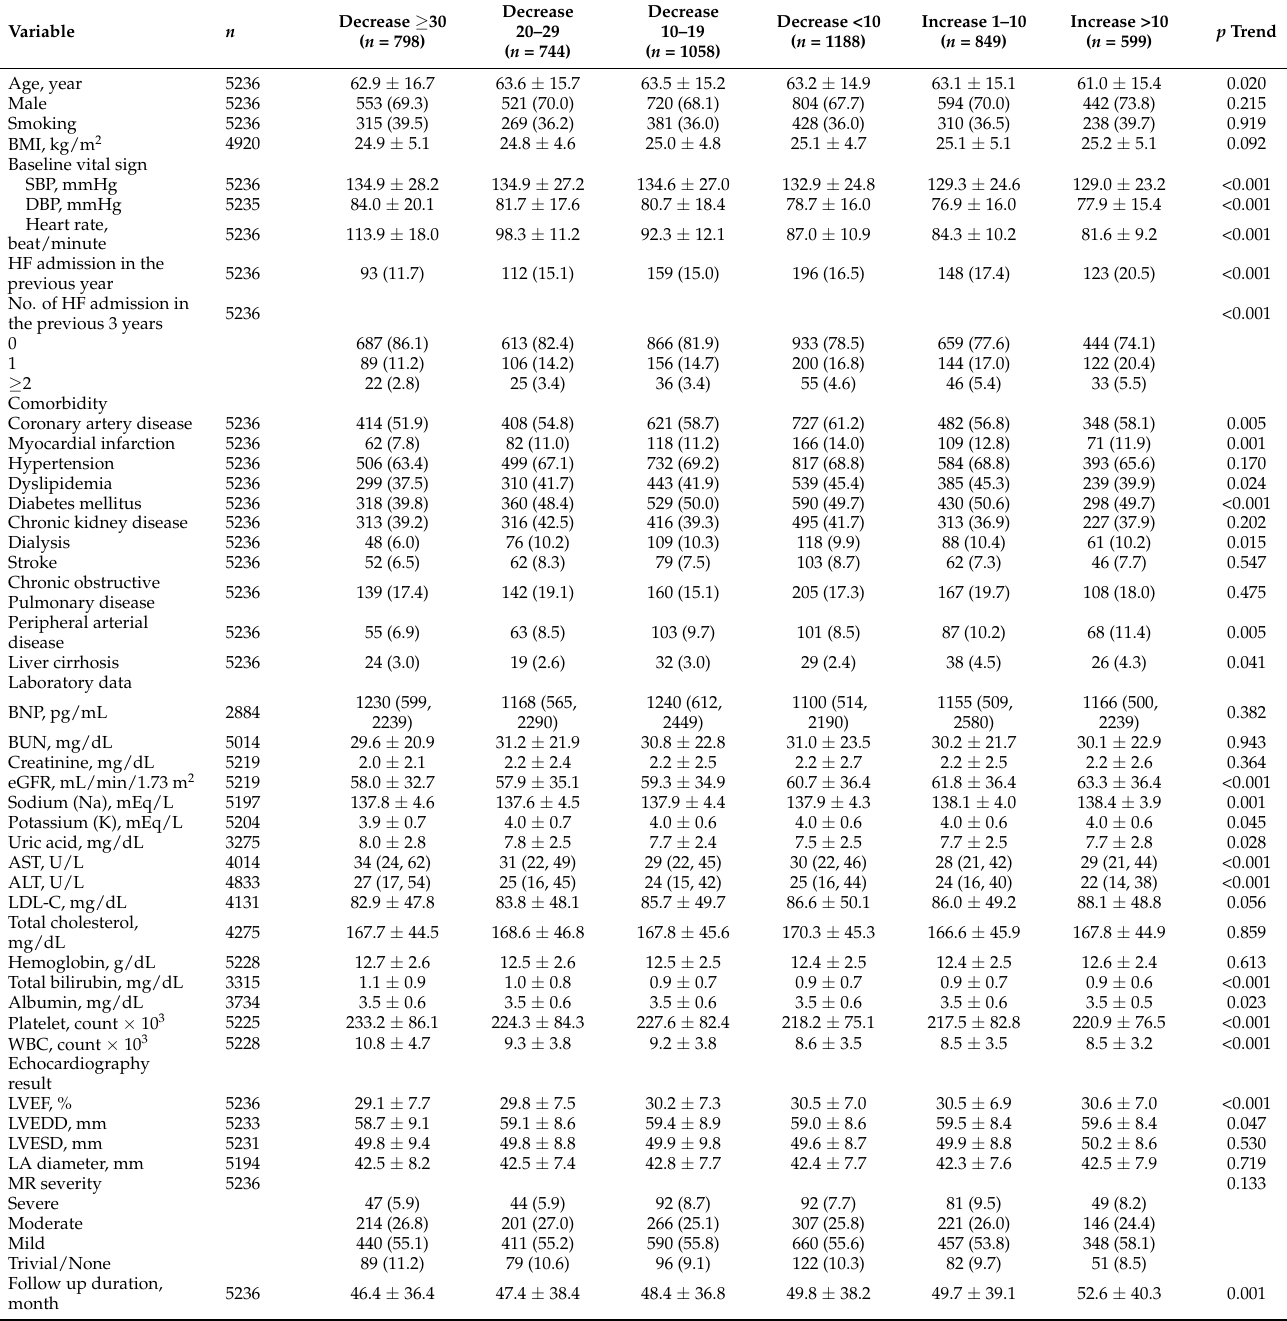
Table 1. Baseline characteristics, comorbidities, laboratory data, and echocardiography results of patients grouped by changes in heart rate from the admission day to the 90th day after